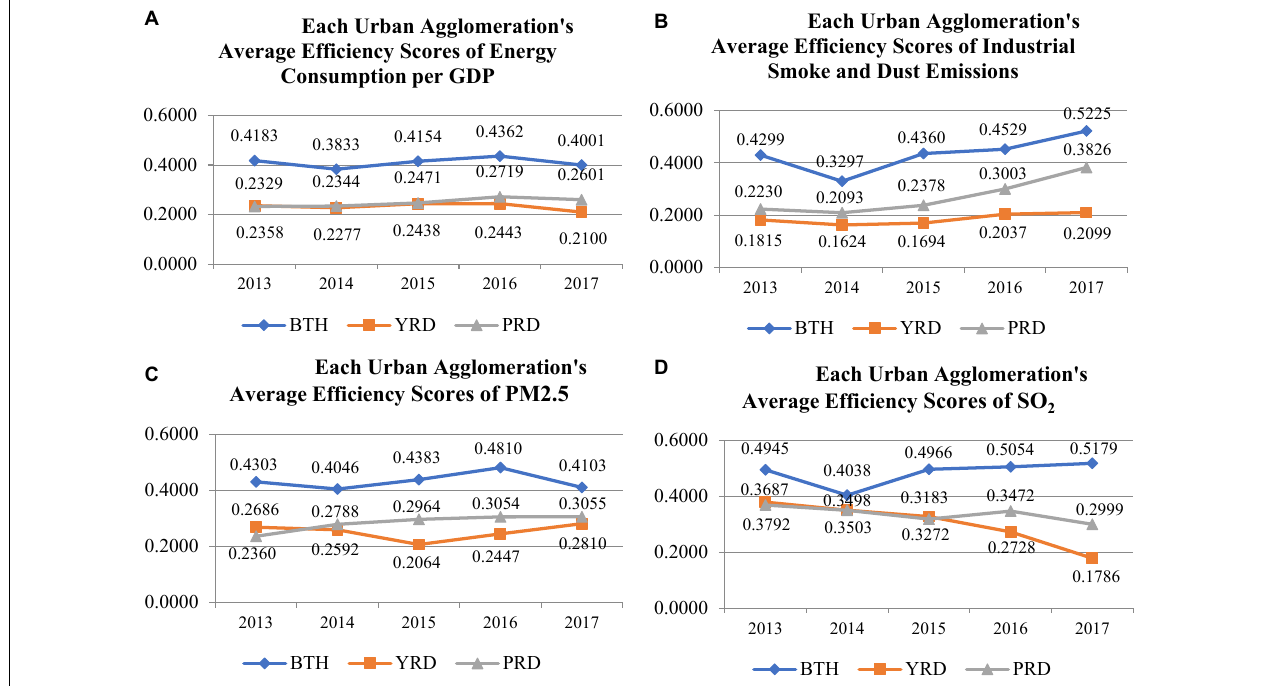
FIGURE 5 | (A–D) Average scores of each index of the three major urban agglomerations. (A) Each urban agglomeration’s average efficiency scores of energy consumption per GDP. (B) Each urban agglomeration’s average efficiency scores of industrial smoke and dust emissions. (C) Each urban agglomeration’s average